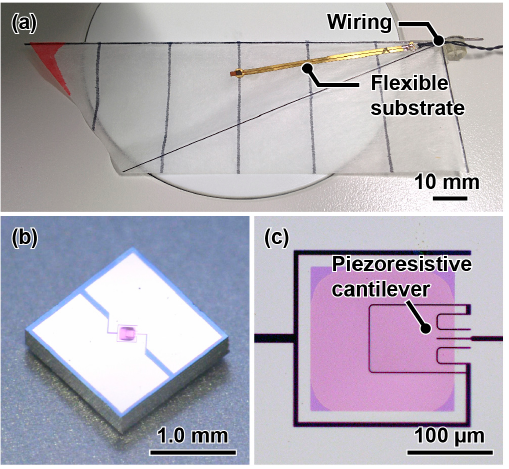
Figure 2. Photographs of the attached sensor ( a ); sensor chip ( b ); and the sensor element ( c ). A Cu/polyimide/Cu flexible electrode was used as the sensor attachment on the wing surface. The sensor chip was electrically connected to the edge of the flexible electrode, and insulated wires were connected to the opposite side of the electrode edge. Beeswax was used to attach the electrode to the wing surface such that the sensor was positioned above the hole. Each signal was sent via two wires from the leading edge of the wing to the ornithopter tail. The signals were sent from the tail to an external bridge and amplifier circuit. The combined weight of the electrode and sensor chip was approximately 4.5 mg, less than 5% of the wing weight.